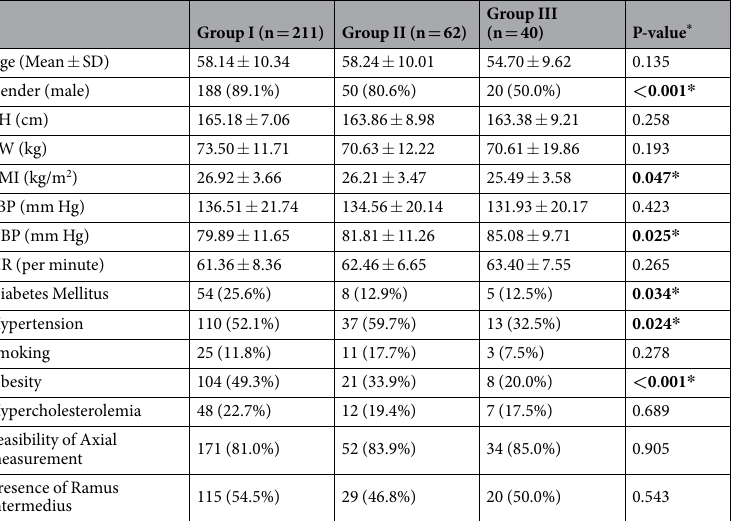
Table 1. Demographic data and risk factors of the subjects in the three groups. Group I = presence of significant stenosis of either the left anterior descending artery, the left circumflex artery or both. Group II = presence of plaques in either the left anterior descending artery, the left circumflex artery or both, but without associated significant stenosis, Group III = Normal subjects who had negative findings on coronary CT angiography, with a zero calcium score. BW = body weight; BH = body height; BMI = body mass index; SBP = systolic blood pressure; DBP = diastolic blood pressure; LCBA = visualization of the left coronary bifurcation within 1 to 3 axial CT images. * Denotes statistical significance, with a p value <